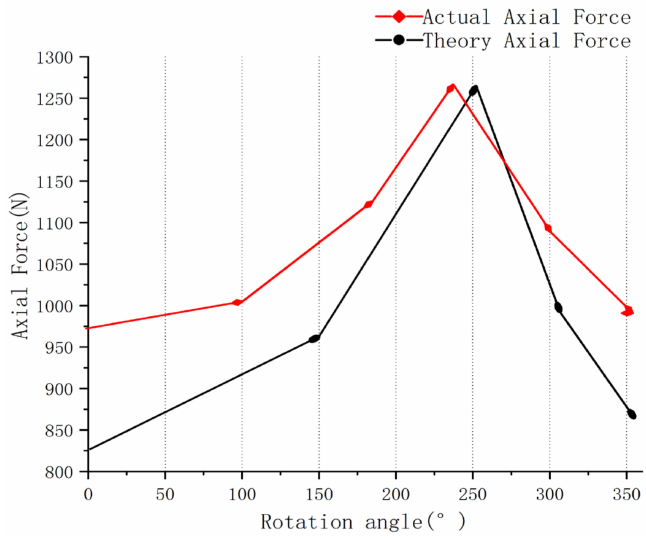
Figure 4. Initial state.